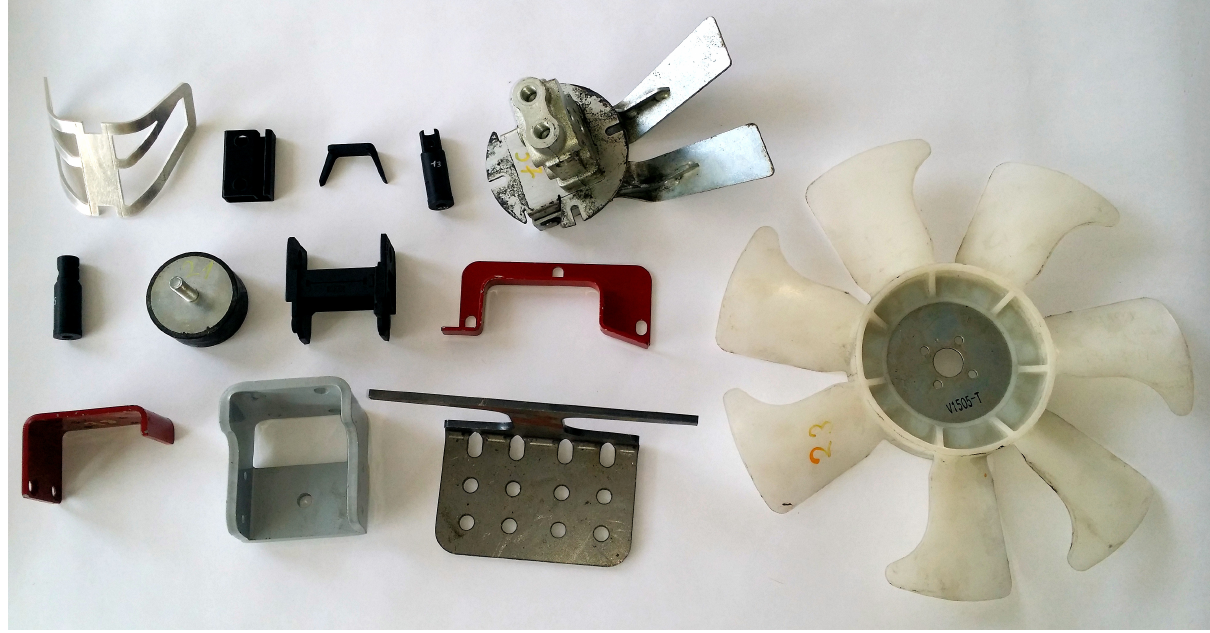
Figure 9. Subset of the collection of 29 mechanical